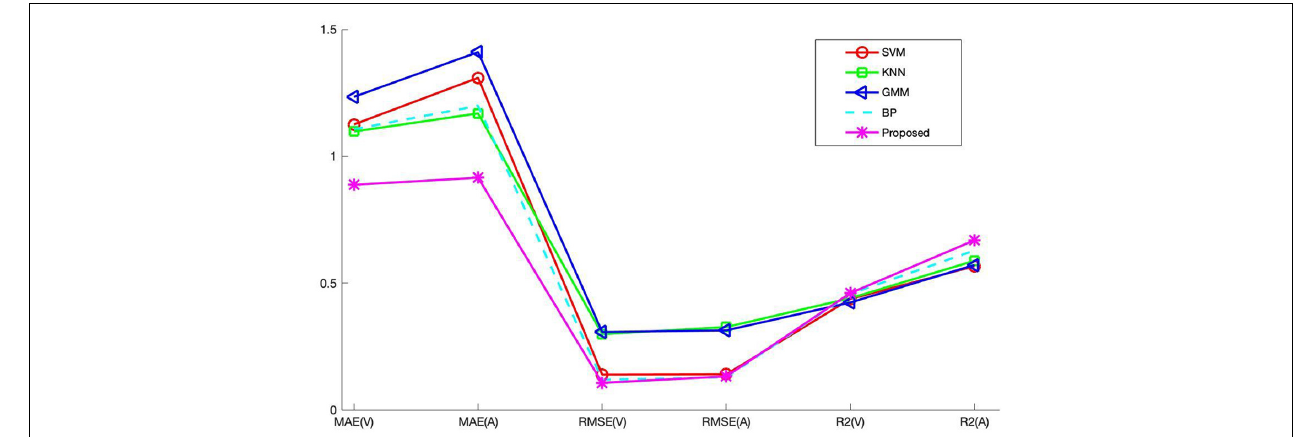
FIGURE 6 | Comparison chart of recognition